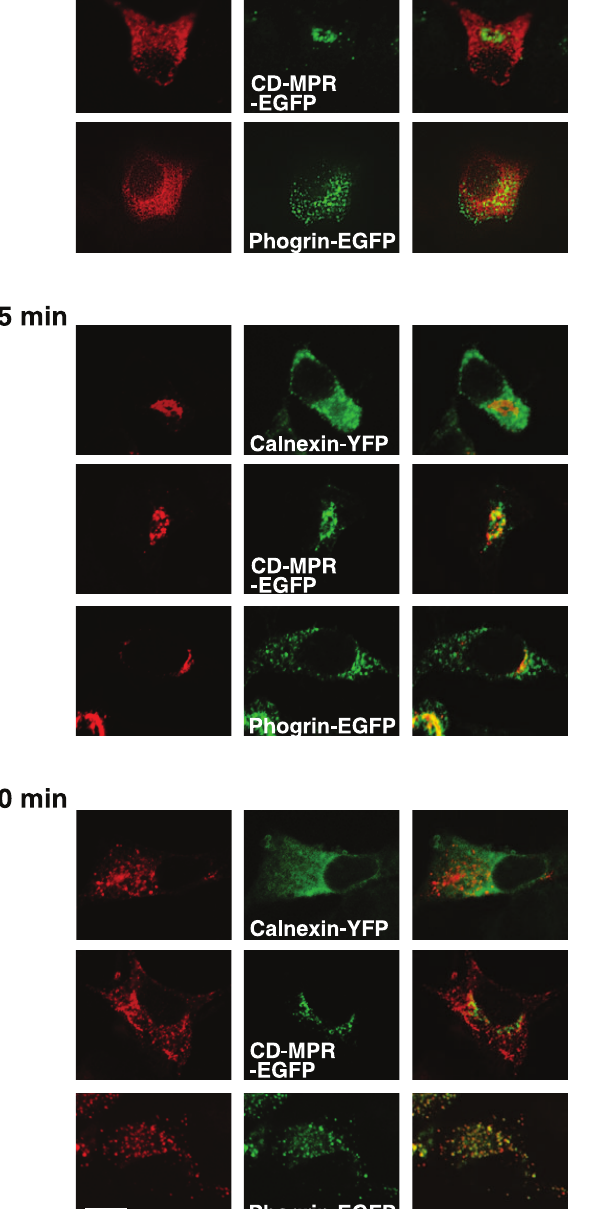
Figure 2. Biosynthetic pathway of insulin-HT monitored by fluorescent microscopy. MIN6 cells transiently transfected with insulin-HT plus calnexin-YFP, insulin-HT plus M6PR-EGFP, or insulin-HT plus phogrin-EGFP were treated with blocking probe for 1 hour. After removal of excess probe, the cells were labeled with HT-TMR for 1 hour at 15 u C (top panels). The cells were subsequently chased at 37 u C for 15 (middle panels) and 30 minutes (bottom panels), respectively. Fluorescent images were analyzed by confocal microscopy. Experiments were repeated three times with reproducible results. Bar, 10 m m.